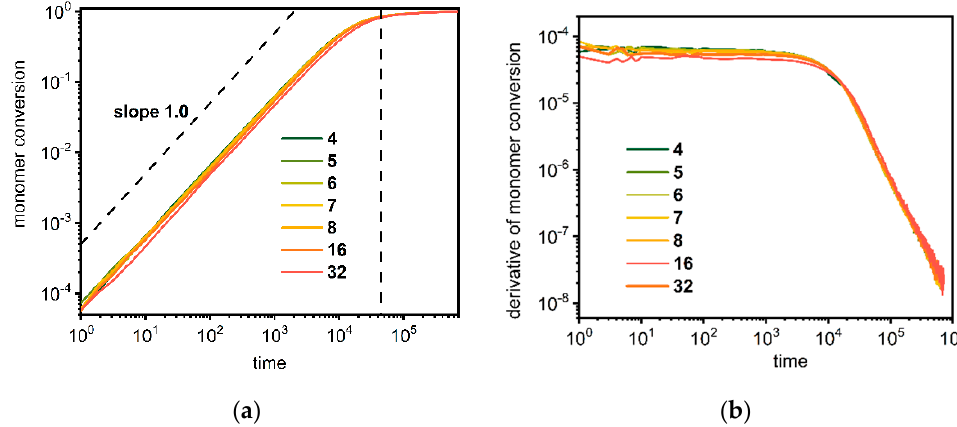
Figure 1. Conversion of a monomer ( a ) and its derivative ( b ) as a function of time during polymerization of star-branched polymers. The number of arms is given in the ( b ) legend.